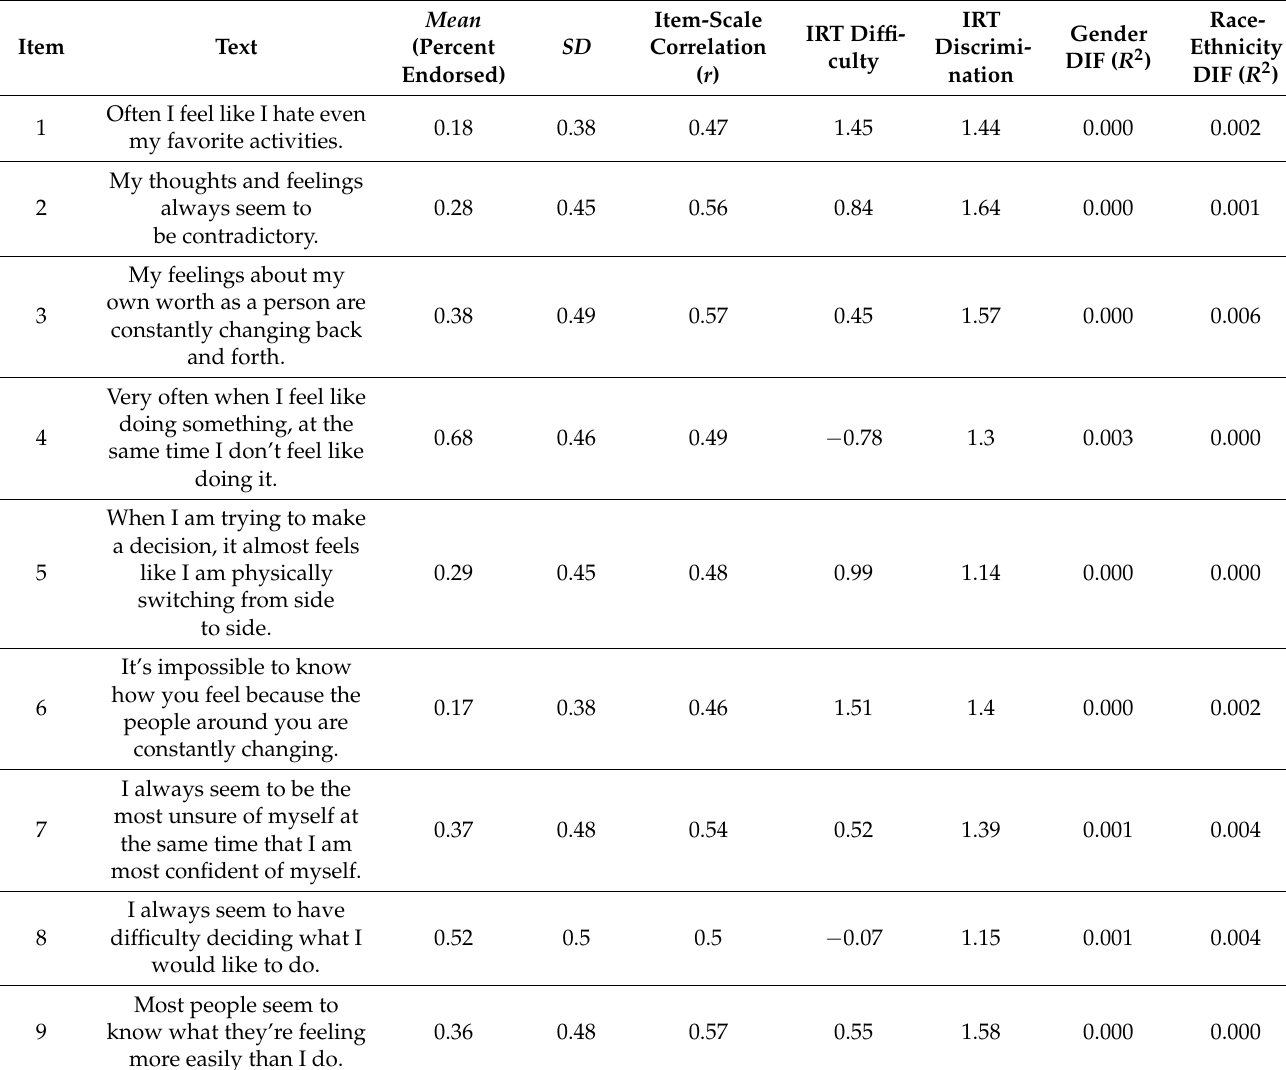
Table 1. SAS items and descriptive